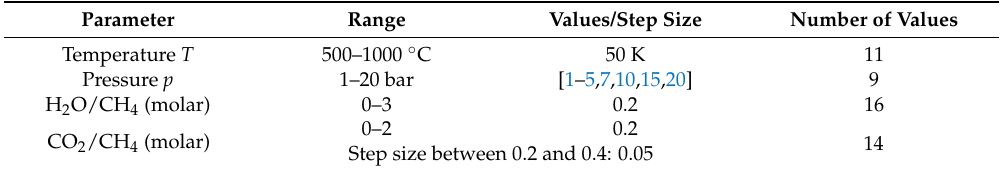
Table 2. Range and interval for variation of model parameters.